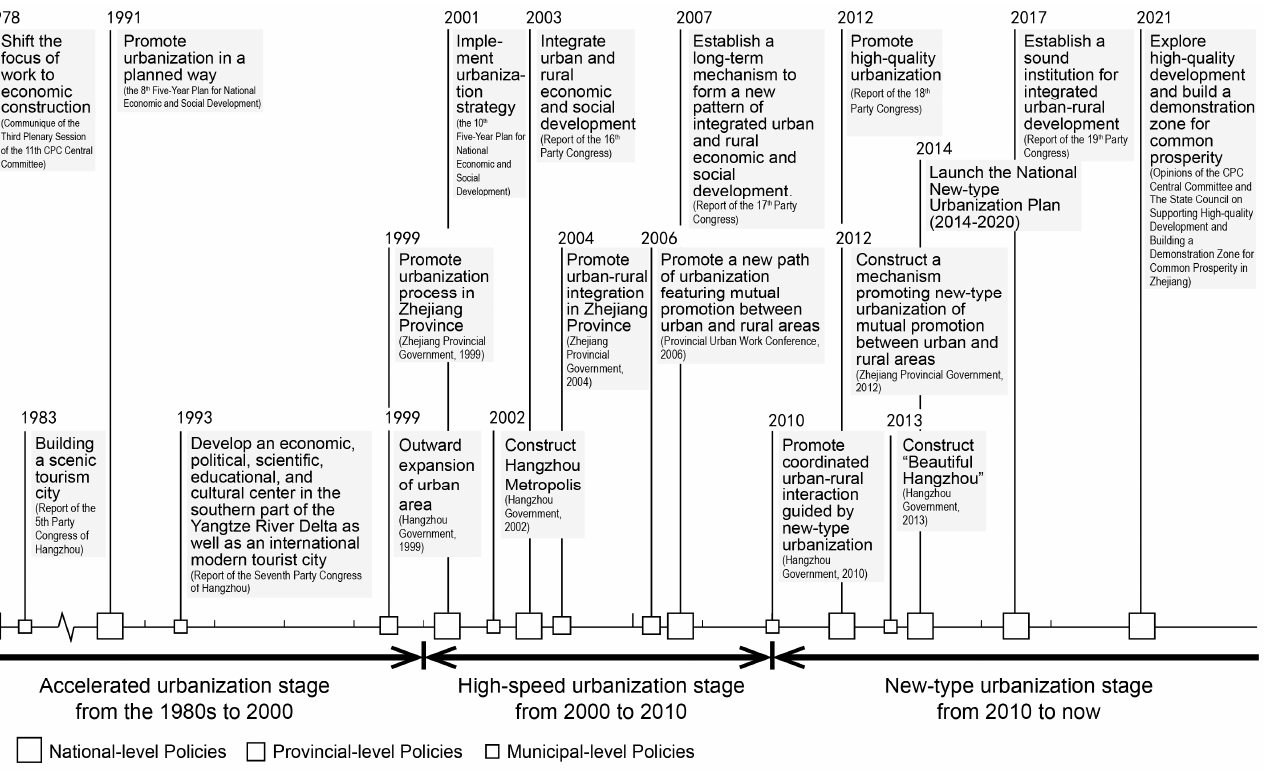
Figure 5. A stage-by-stage review of Hangzhou’s urbanization process.